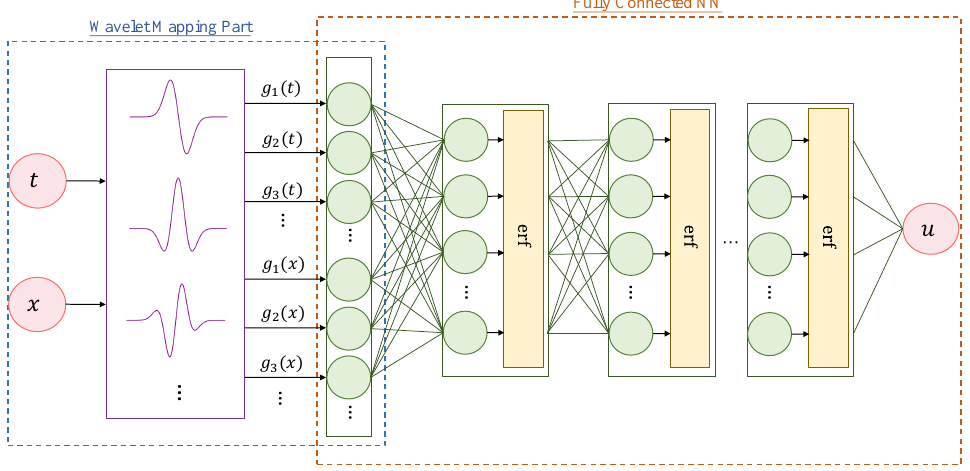
Figure 1. Architecture of deep wavelet neural